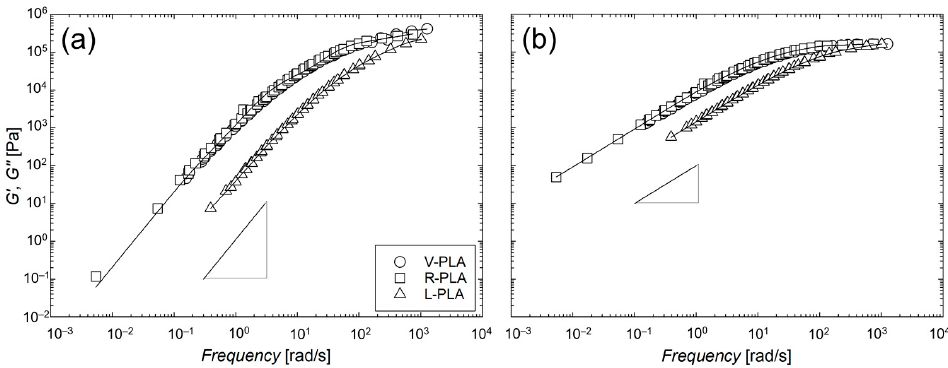
Figure 3. Master curve of storage G’ ( a ) and loss G’’ ( b ) moduli against reduced frequency of three materials at the reference temperature of 170 °C. The solid lines through data points represent best fitting with a 5-mode Maxwell model. Limiting slopes of 2 and 1 are also represented for